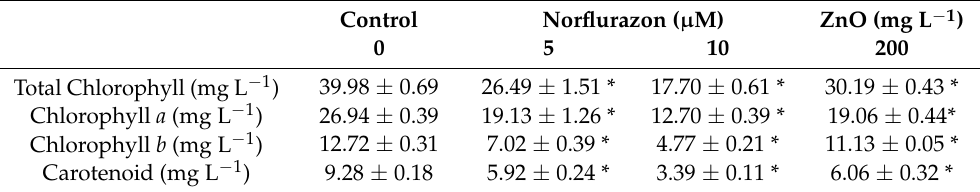
Table 2. Total chlorophyll, chlorophyll a , chlorophyll b , and carotenoids of CC-4414. All data are means ± SD of three biological replicates. Significant differences between the control and each condition are indicated by asterisks (*) ( p <